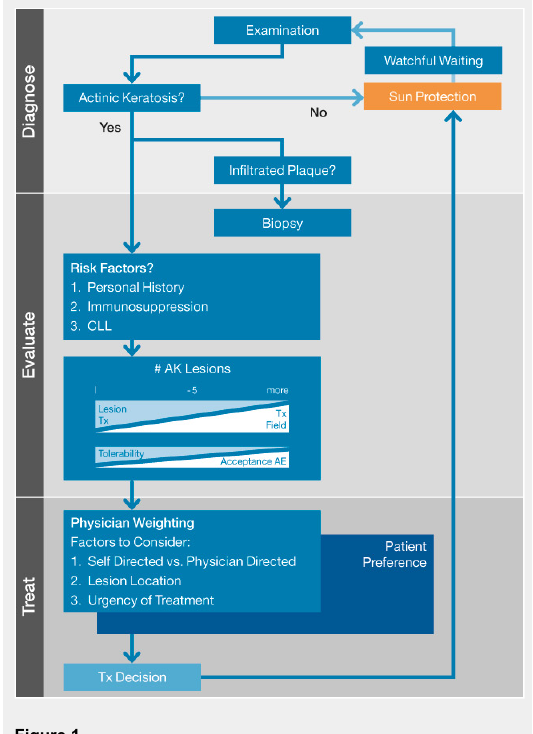
Actinic keratosis and field cancerization treatment algorithm The algorithm is intended to aid in the treatment decision process for actinic keratosis and field cancerization and is not intended to replace a physician’s best judgement on the most appropriate treatment path for each individual